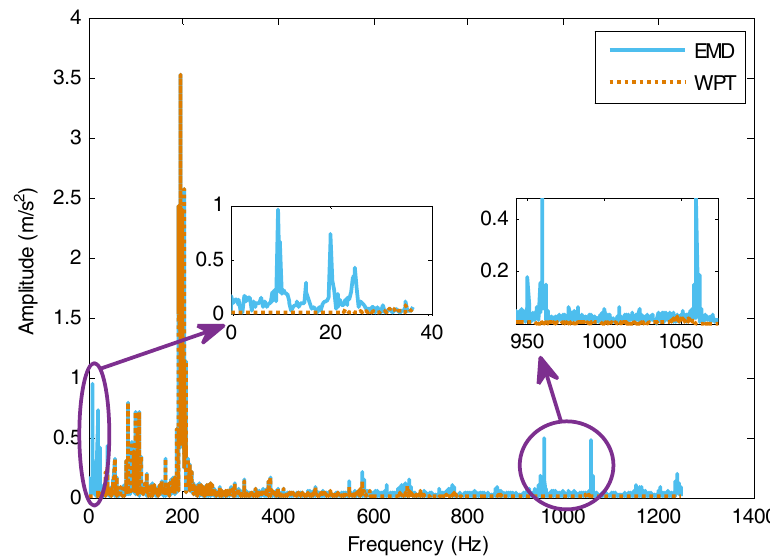
Figure 14. The constructed signals in the frequency domain by EMD and WPT.